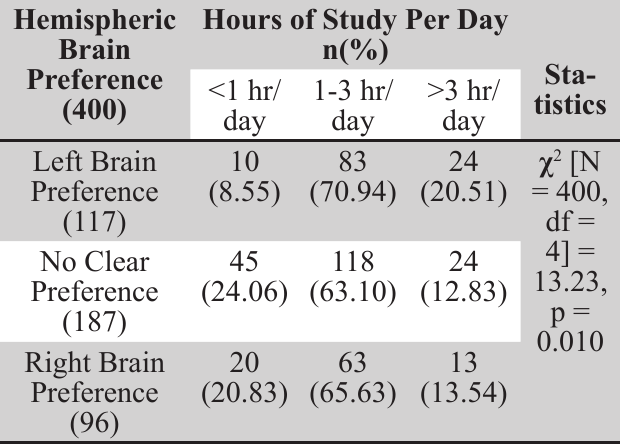
Table 3: Hemispheric brain preference and study hours per